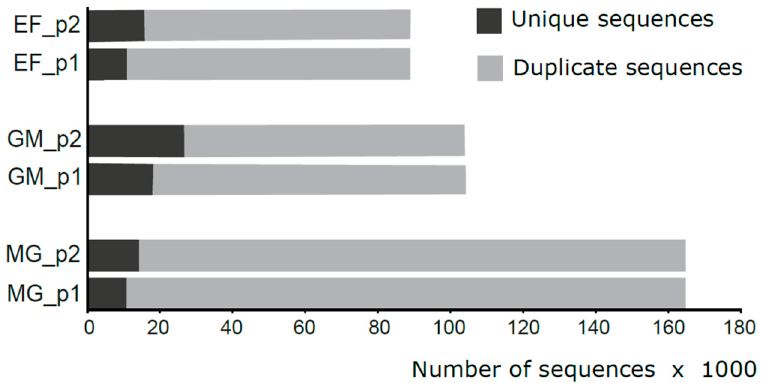
Figure 1. Unique and duplicate sequences of the amplified bacterial 16S rRNA gene fragment (two paired-end sequences primers described as p1 and p2) obtained by three commercial laboratories (EF, GM and MG).